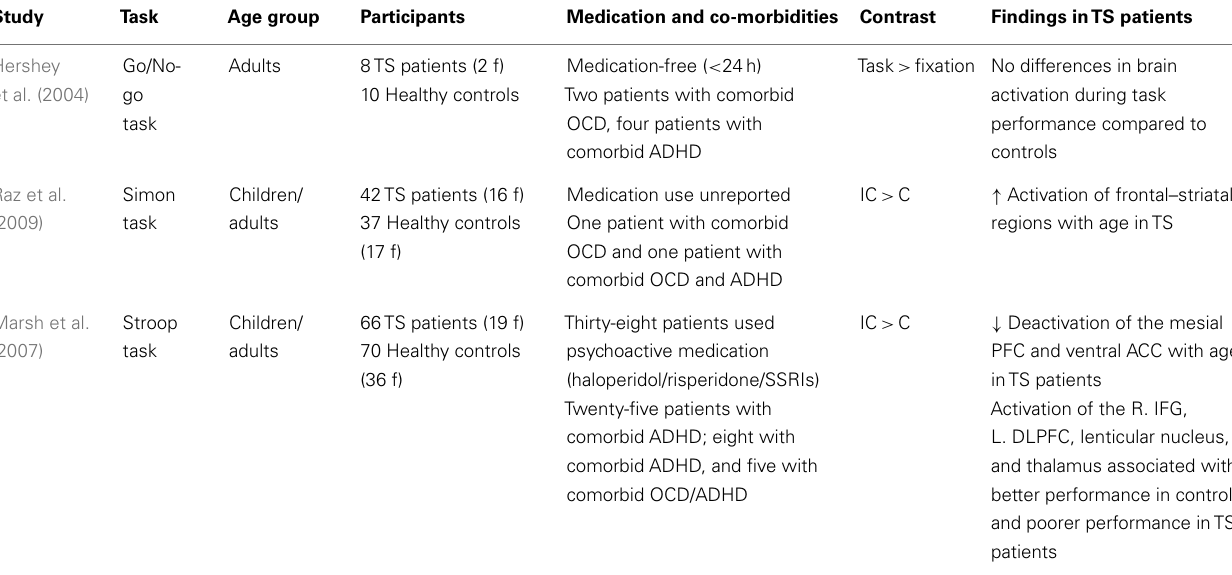
Table 3 | Overview of fMRI studies that have used interference control tasks and response inhibition tasks in patients withTourette’s syndrome